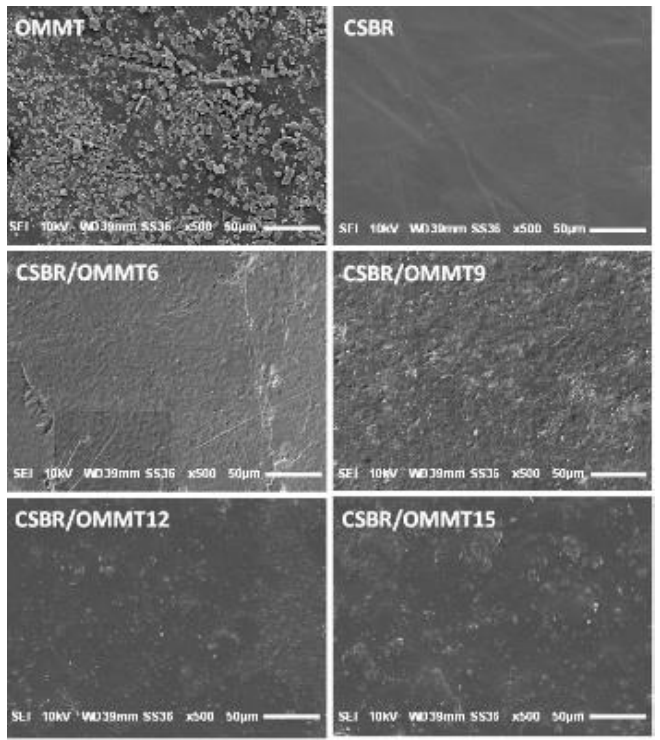
Figure 3. SEM micrographs of: ( A ) OMMT nanoparticles; ( B ) CSBR; ( C ) CSBR/OMMT3; ( D ) SEM micrographs of: (A) OMMT nanoparticles; (B) CSBR; (C) CSBR/OMMT6; CSBR/OMMT6; ( E ) CSBR/OMMT9; ( F ) CSBR/OMMT12; ( G ) CSBR/OMMT15 systems. (D) CSBR/OMMT9; (E) CSBR/OMMT12; (F) CSBR/OMMT15